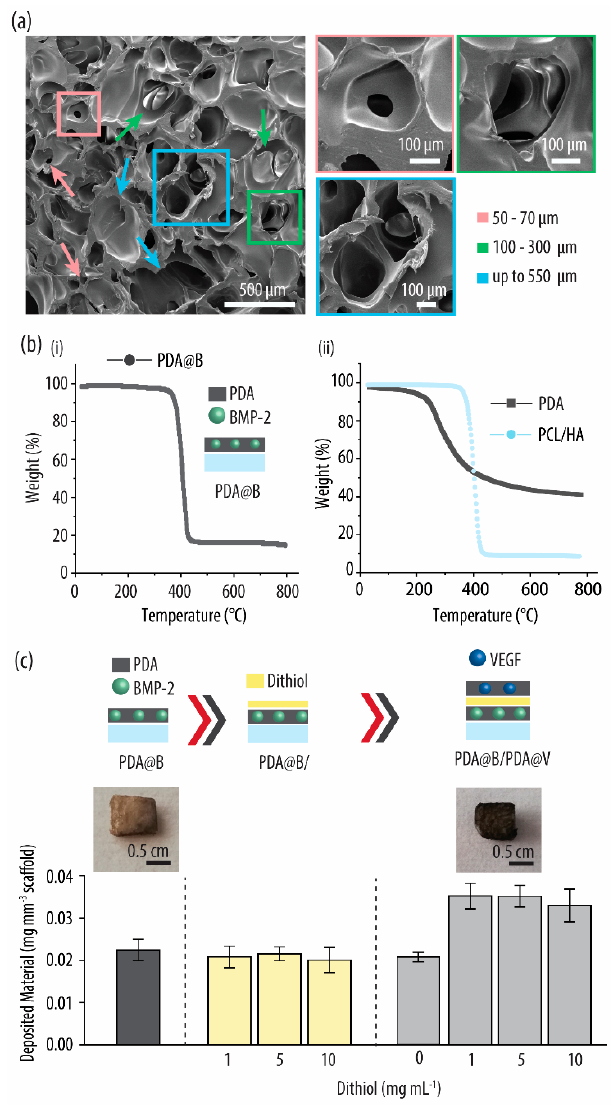
Figure 1. ( a ) Representative scanning electron microscopy images of a cross section of the PCL/HA composite scaffolds: while the pink arrows indicate pores of a size of 50–70 µm, the green and blue arrows indicate macropores of 100–300 µm and extra-large pores up to 550 µm, respectively. ( b ) Thermal degradation of the PCL/HA-based scaffold coated by a polydopamine (PDA) layer incorporating BMP-2 (PDA@B) (i) and the corresponding controls of bare PCL/HA scaffolds and PDA only. ( c ) Amount of deposited material onto the scaffolds as assessed by thermogravimetric analysis after each deposition step depending on the concentration of dithiol employed: PCL/HA scaffolds are first coated by a PDA@B layer and incubated in a dithiol solution at three different concentrations. Finally, a PDA layer containing VEGF (PDA@V) is adsorbed on a second deposition step